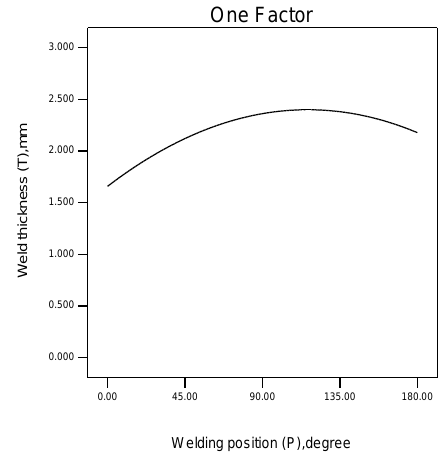
Figure 12. Influence of welding position on weld thickness.